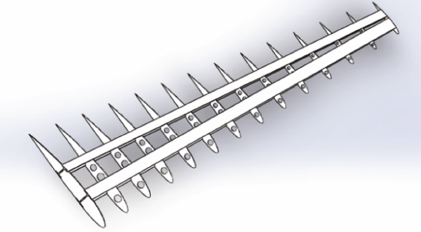
Figure 10: Model of the overall internal skeleton with the thickness of the skin being 12